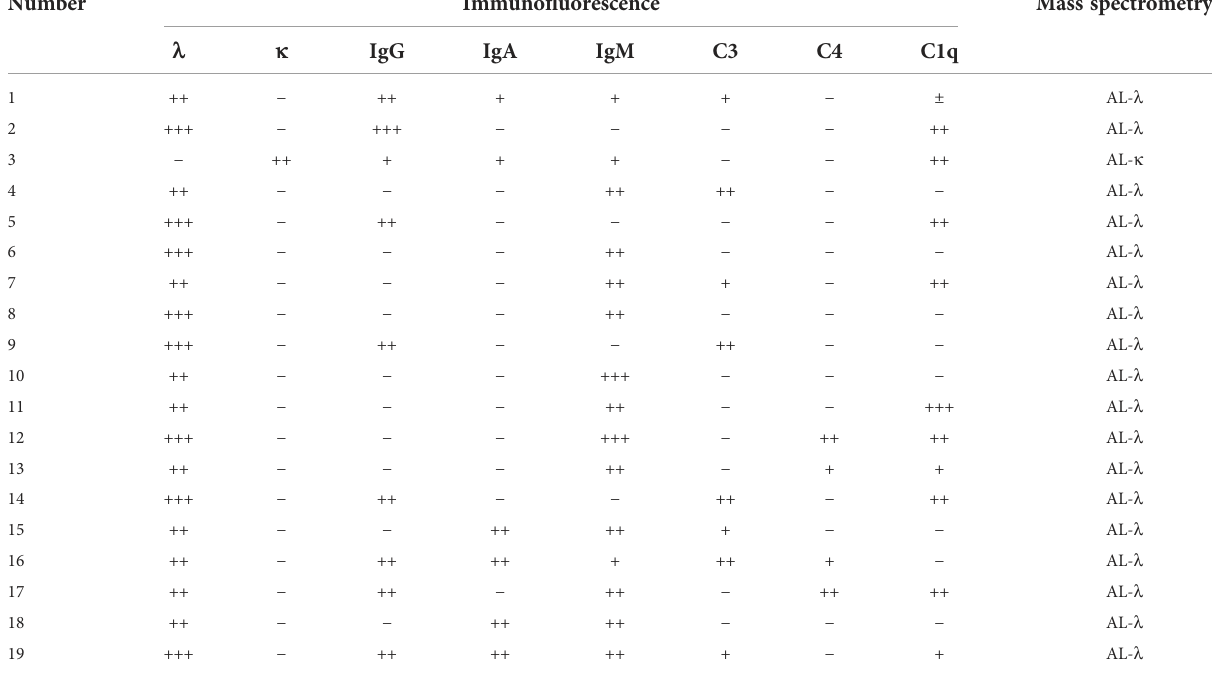
TABLE 1 Immuno fl uorescence and mass spectrometric analyses of renal biopsy specimens from 19 patients with immune complex deposition.